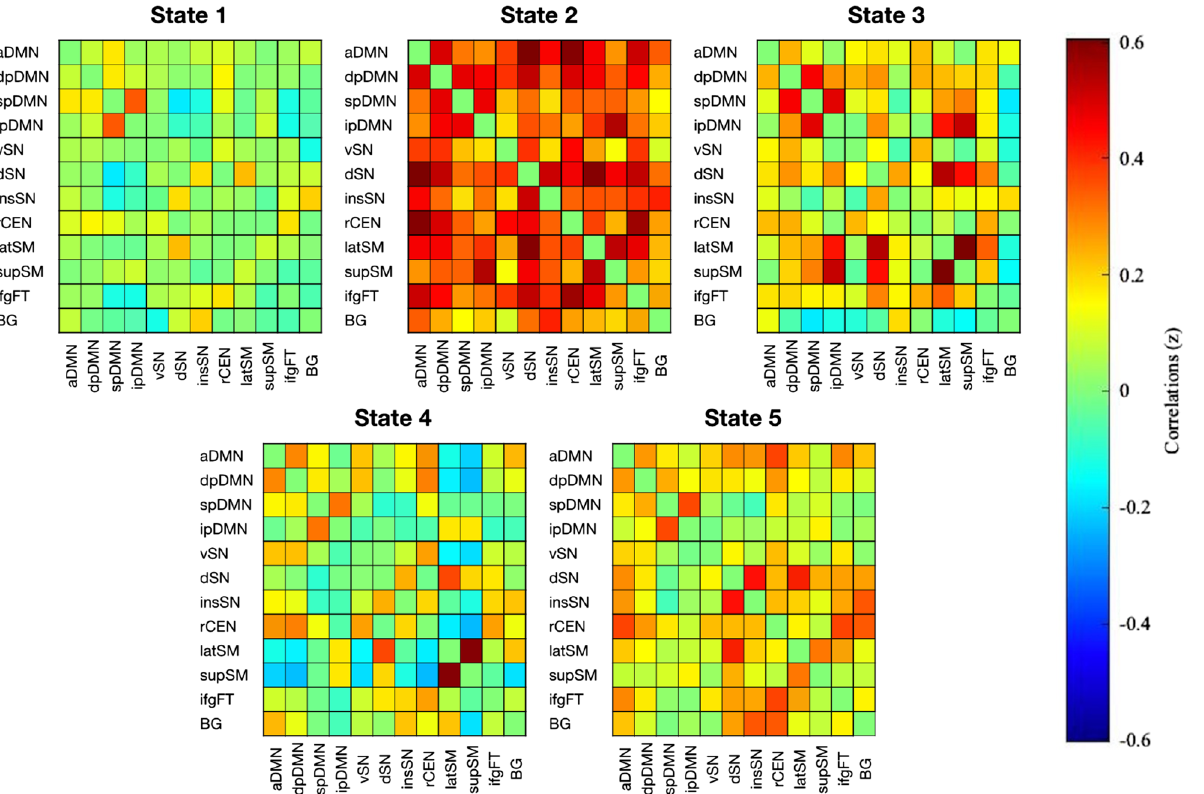
Figure 2. Cluster centroids representing different states of connectivity between network components across both groups and time points. Colors indicate z-transformed connectivity values with warm colors indicating high values and cool colors indicating low values. aDMN anterior default mode network, dpDMN dorsal posterior default mode network, spDMN superior posterior default mode network, ipDMN inferior posterior default mode network, vSN ventral salience network, dSN dorsal salience network, insSN insular salience network, rCEN right central executive network, supSM superior sensorimotor network, latSM lateral sensorimotor network, ifgFT inferior frontal gyrus network, BG basal ganglia network.